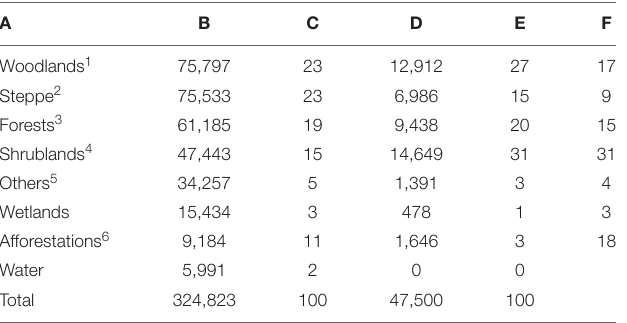
TABLE 2 | (A) Type of vegetation, (B) area occupied by each type, (C) its proportion relative to the area occupied in the study area, (D) burned area per vegetation type, (E) its proportion from the total area burned, and (F) proportion of burned area relative to area occupied by the vegetation type, all of them in the period studied and in the studied